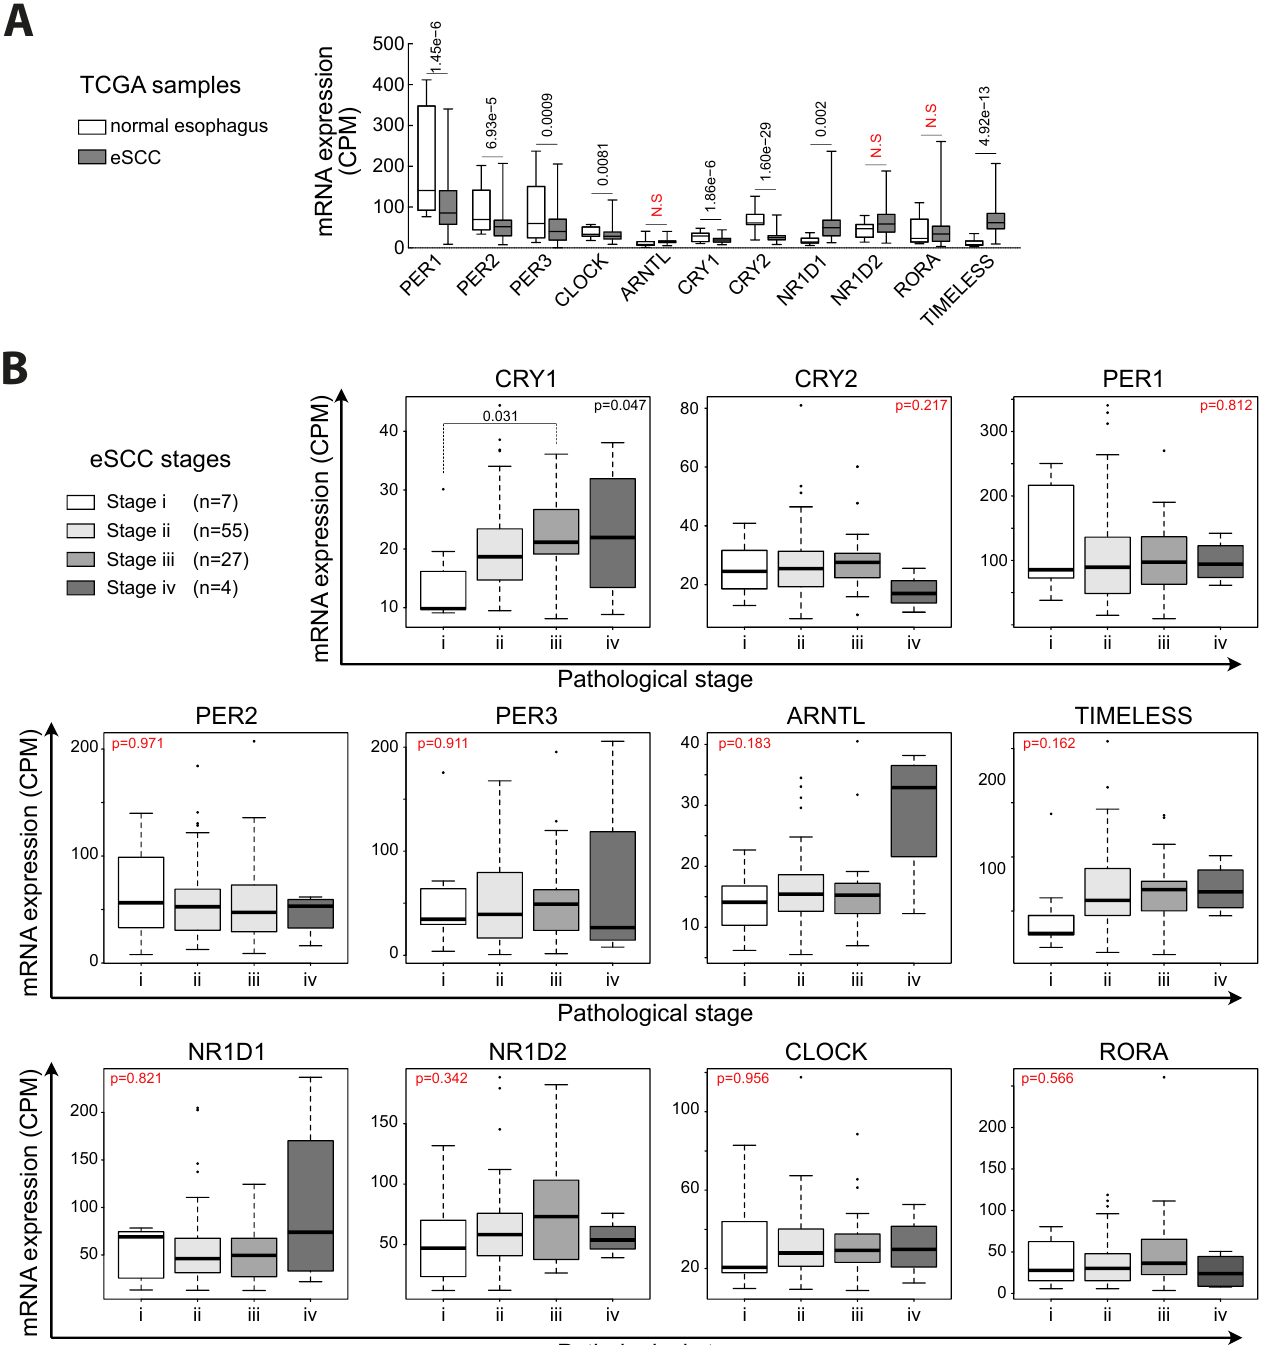
Figure 1. Expression of clock-related genes in human esophageal squamous cell carcinoma (eSCC) samples. ( A ) Expression of clock related genes measured by RNA sequencing in biopsies from control esophagus ( n = 11) and eSCC ( n = 95). Data are represented as boxplots. False discovery rate (FDR) is indicated for each gene. Benjamini–Hochberg method on the p -values was used to control the FDR. ( B ) Expression of clock related genes measured by RNA sequencing in biopsies from eSCC samples depending on their pathological stage. Data are represented as boxplots. Statistics were calculated using a Kruskal–Wallis test followed by a Tukey–Kramer test. p -values < 0.05 are considered as